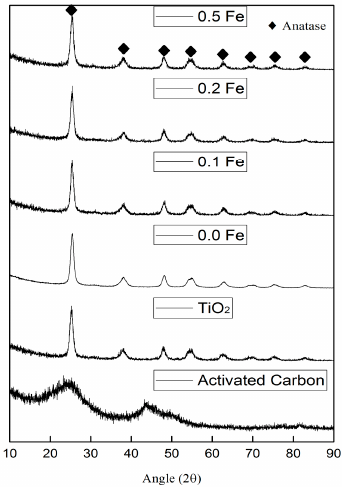
Figure 3. XRD analysis for the photocatalyst with different amounts of Fe content.